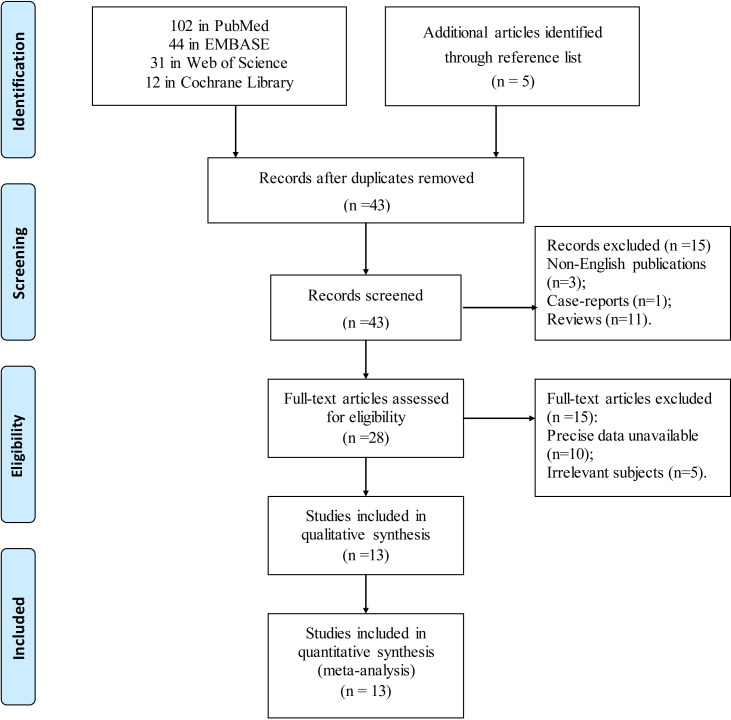
Flow chart of studies identified, excluded and included.